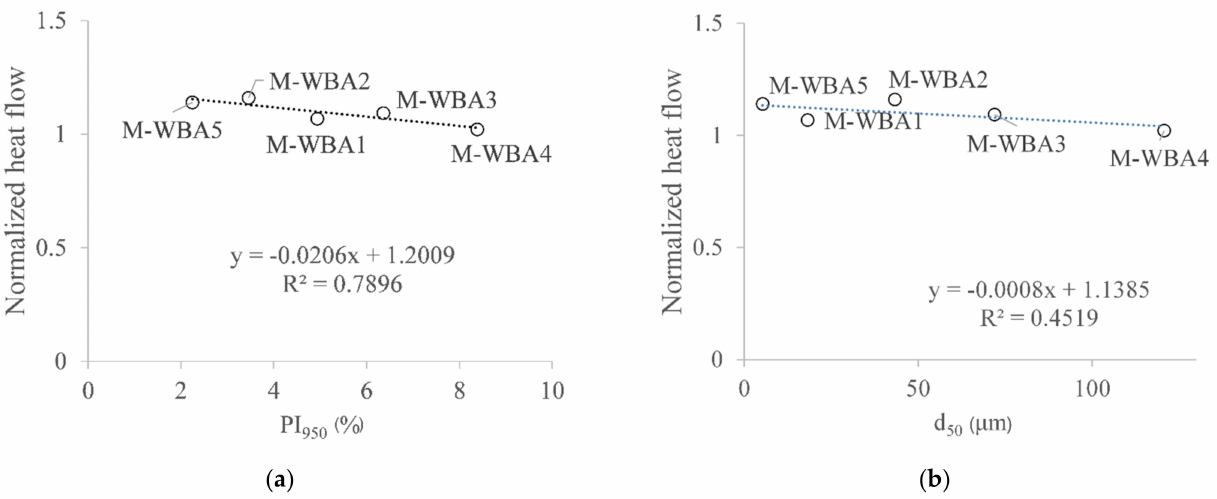
Figure 10. ( a ) Normalized cumulative heat flow after 168 h and PI 950 values after one year of storage of WBA samples; ( b ) normalized cumulative heat flow after 168 h and d 50 of WBA